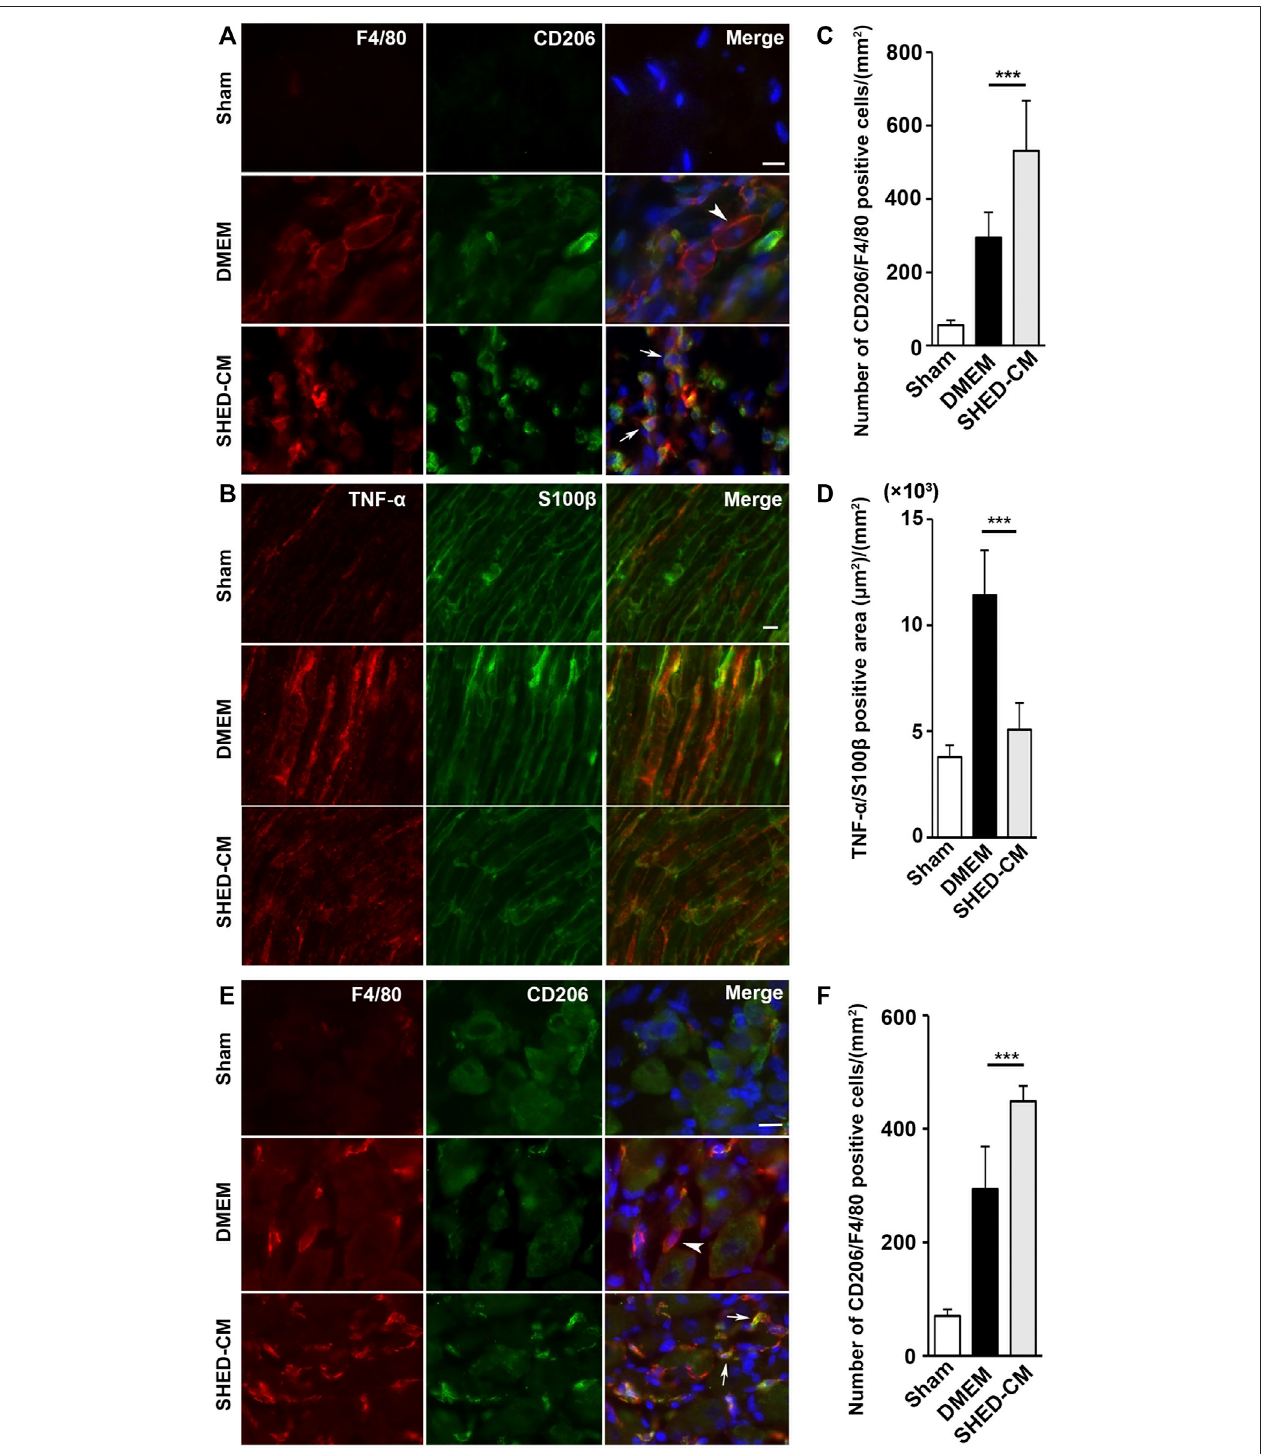
FIGURE 3 | SHED-CM treatment induces M2 macrophages. (A,B) Representative images of immuno fl uorescent staining of CD206, F4/80 (A) and TNF- α , S100 β (B) in SCN. (C,D) Quanti fi cation of CD206 + F4/80 + cell numbers (C) and TNF- α + S100 β + area (D) in SCN. (E) Images ofimmuno fl uorescent staining ofCD206, F4/80 in L4/5 DRG. (F) Quanti fi cation of CD206 + F4/80 + cell numbers in L4/5 DRG. Scale bar: 10 μ m in (A,B,E) . At least 3 non-overlapping sections from 8 animals per group were used to determine the positive cells. Data represent the mean ± SD. Student ’ s t -test ( n = 8, per group); *** p < 0.001. Arrowheads and arrows in (A) and (E) indicate CD206 - F4/80 + and CD206 + F4/80 + , respectively.